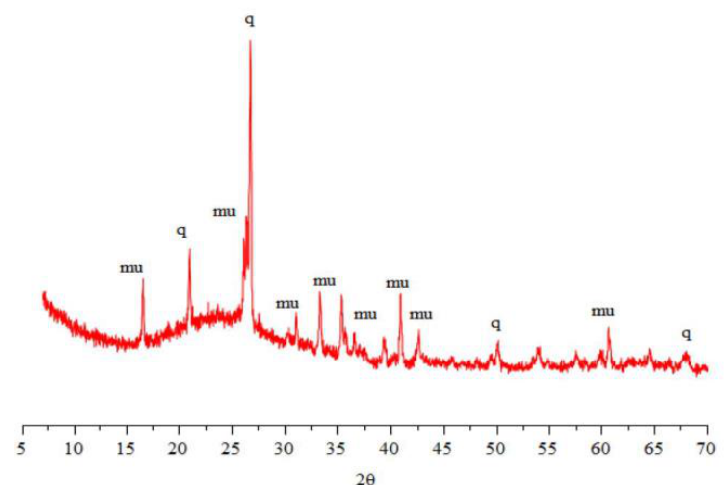
Figure 6. Mineralogical composition of the fly ash obtained by XRD. Table 2. Chemical composition of the fly ash obtained by